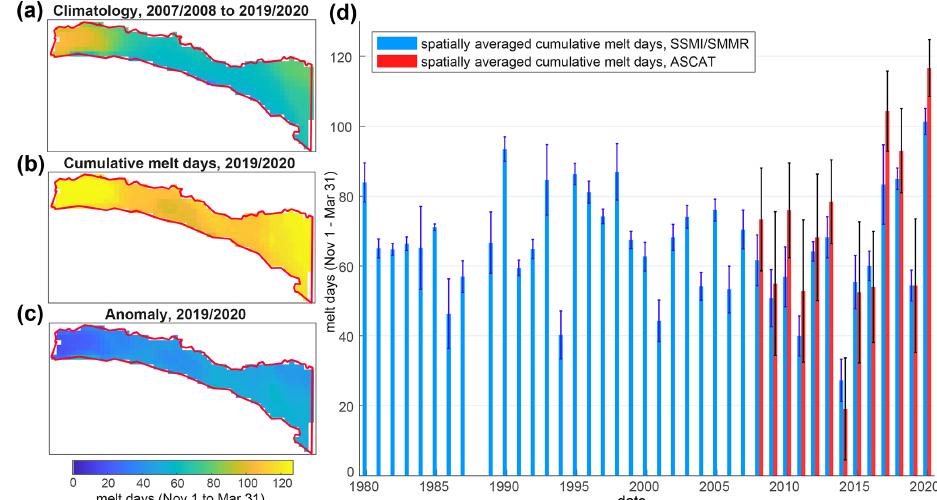
Figure 4. (a–c) Active microwave-derived (i.e. ASCAT) cumulative melt days over the northern GVIIS AOI (see Fig. 1b for location, red outline), relative to the passive microwave time series (Fig. 3a–c). (a) Mean cumulative melt days for austral summers from 2007/2008 to 2019/2020. (b) Cumulative melt days in the 2019/2020 austral summer. (c) Anomaly of the 2019/2020 melt season (i.e. b minus a ). (d) Red bars represent microwave scatterometer-derived, spatially averaged (i.e. over the AOI) cumulative melt days for austral summers from 1979/1980 to 2019/2020, with red error bars showing ± 1 standard deviation from the mean. Blue bars show microwave-radiometer- derived, spatially averaged cumulative days from 1979/1980 to 2019/2020, with blue error bars showing ± 1 standard deviation from the mean. The x axis dates indicate the second year of each austral summer, e.g. 2020 = 2019/2020.